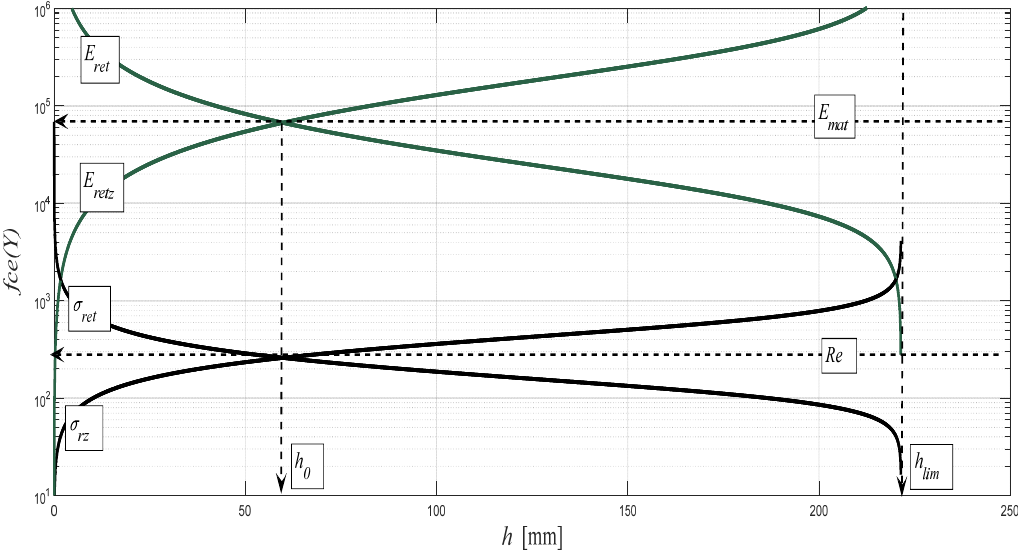
Figure 8. Theoretical identification of position in the diagram and of the values of dependence ( h 0 , Re ) = f ( h ), which can be analogically realized for the dependencies ( h 0 , Re ) = f ( ε ), or ( h 0 , Re ) = f ( A ) at tensile tests; material: aluminium alloy AW6082T6.